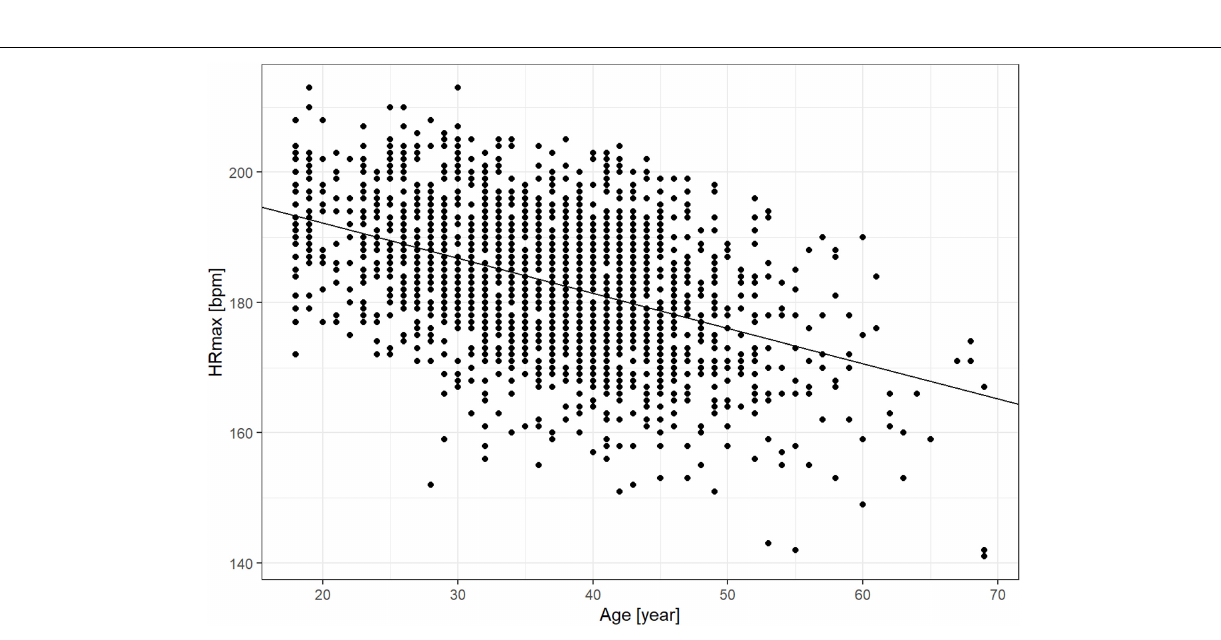
Frontiers in Physiology |